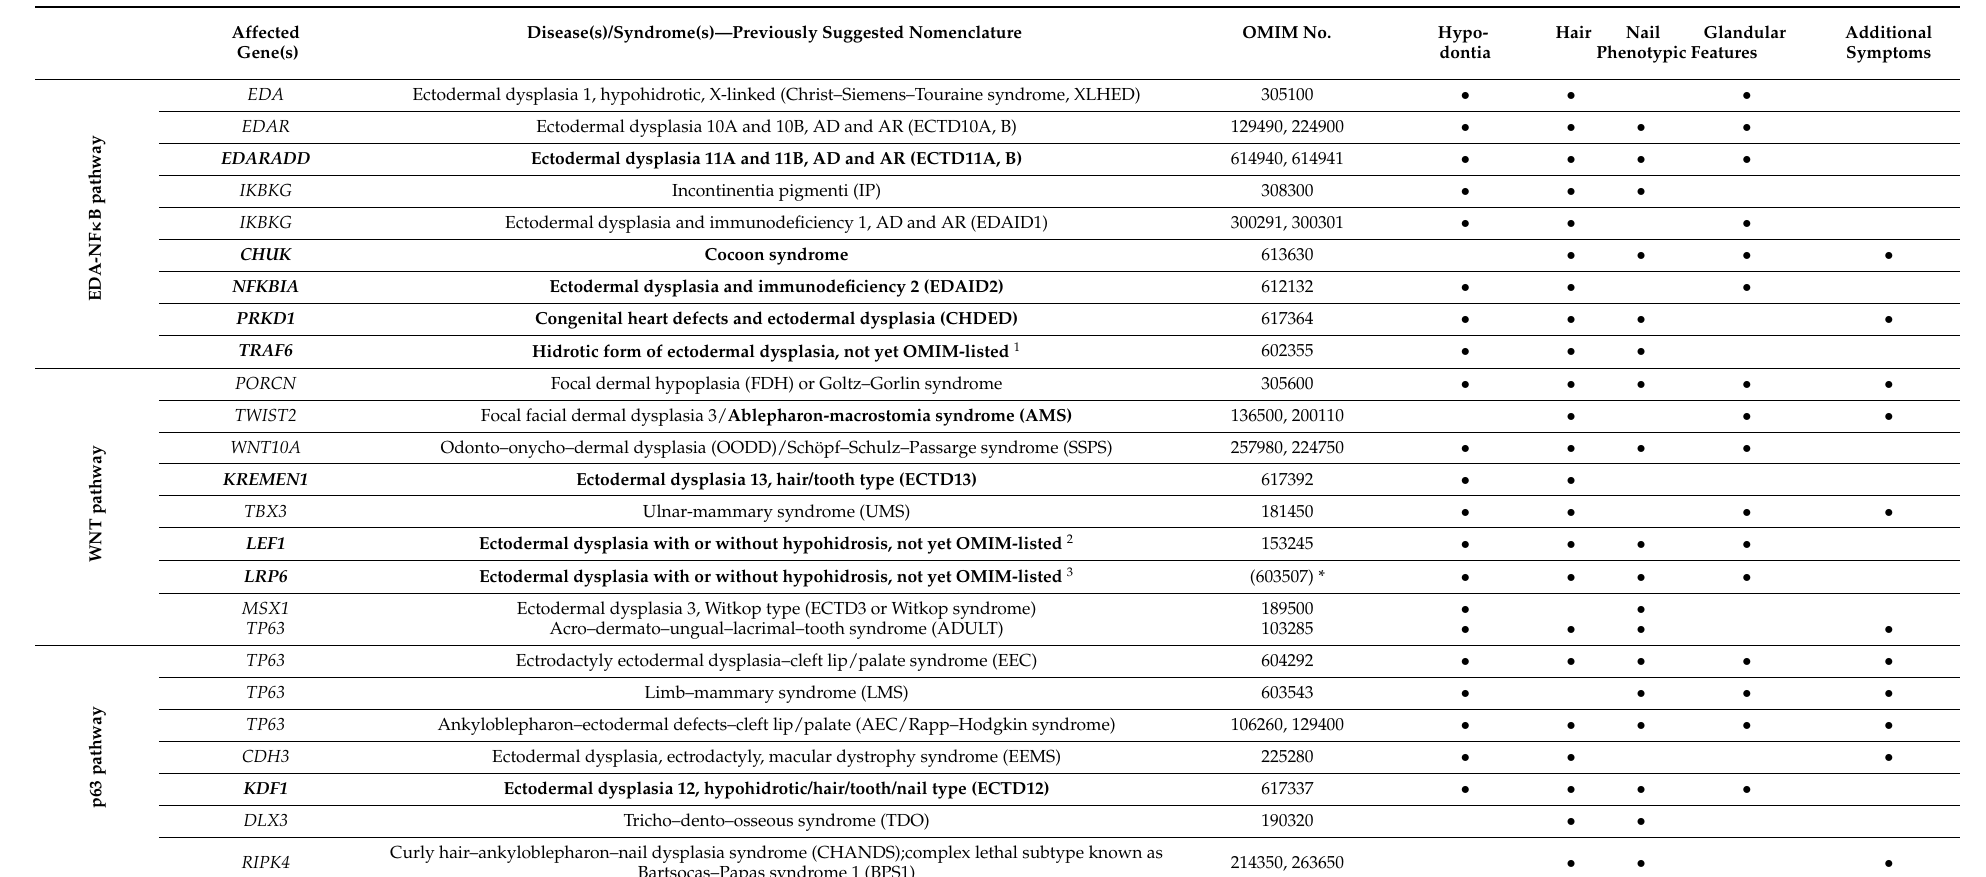
Table 1. Updated classification of the ectodermal dysplasias with 15 newly added syndromes (bold). * in OMIM only described as isolated tooth agenesis so far 1 [11,12]; 2 [13,14]; 3 [15], (Peschel et al., 2022).